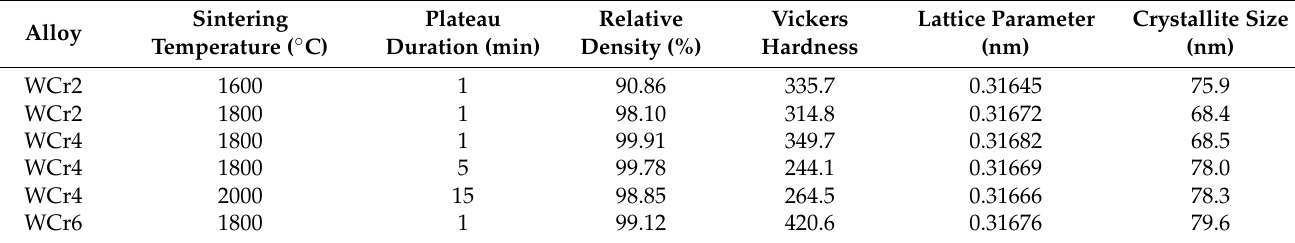
Table 3. Relative density, Vickers hardness and Rietveld refinement results on SPS-densified samples. In bulk are the samples described more specifically in the